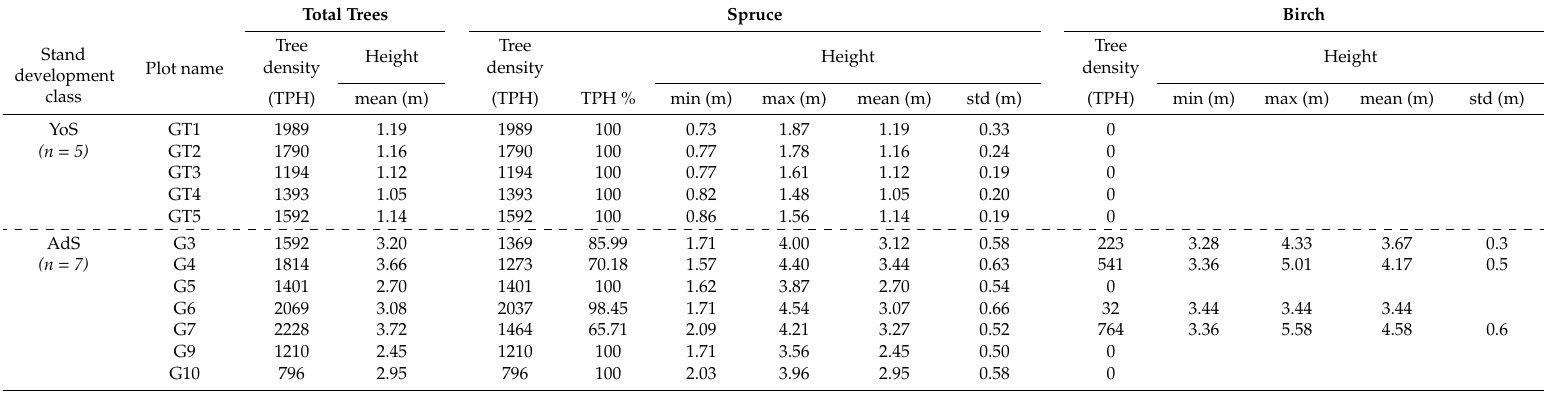
Table 1. Tree density and height variation in sample plots. YoS: young seedling stands; AdS: advanced seedling stands; min, max, mean, and std: minimum, maximum, mean, and standard deviation of field-measured tree heights, respectively; TPH%: proportion of spruce trees over birch (TPH: trees per hectare, Height unit: meter). Total Trees Spruce Birch Stand development class